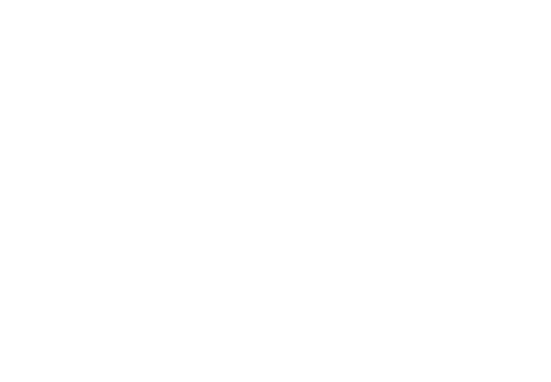
Table 6. ANFIS network processing